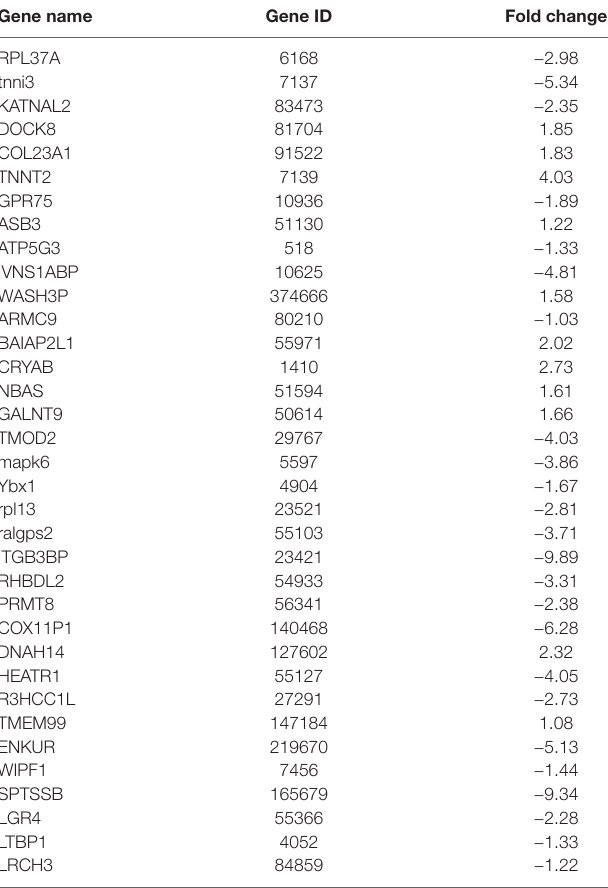
TABLE 5 | The identified genes affected by